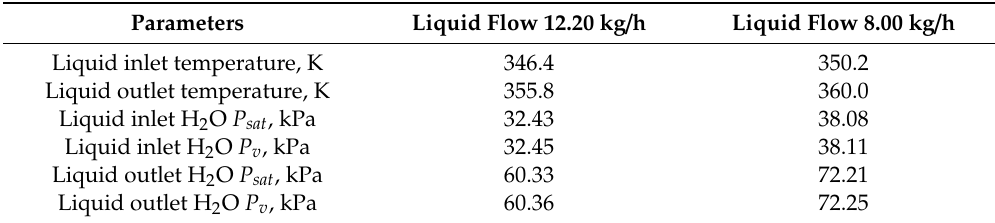
Table 7. Changes in water vapor pressures when the liquid flow rate was reduced.